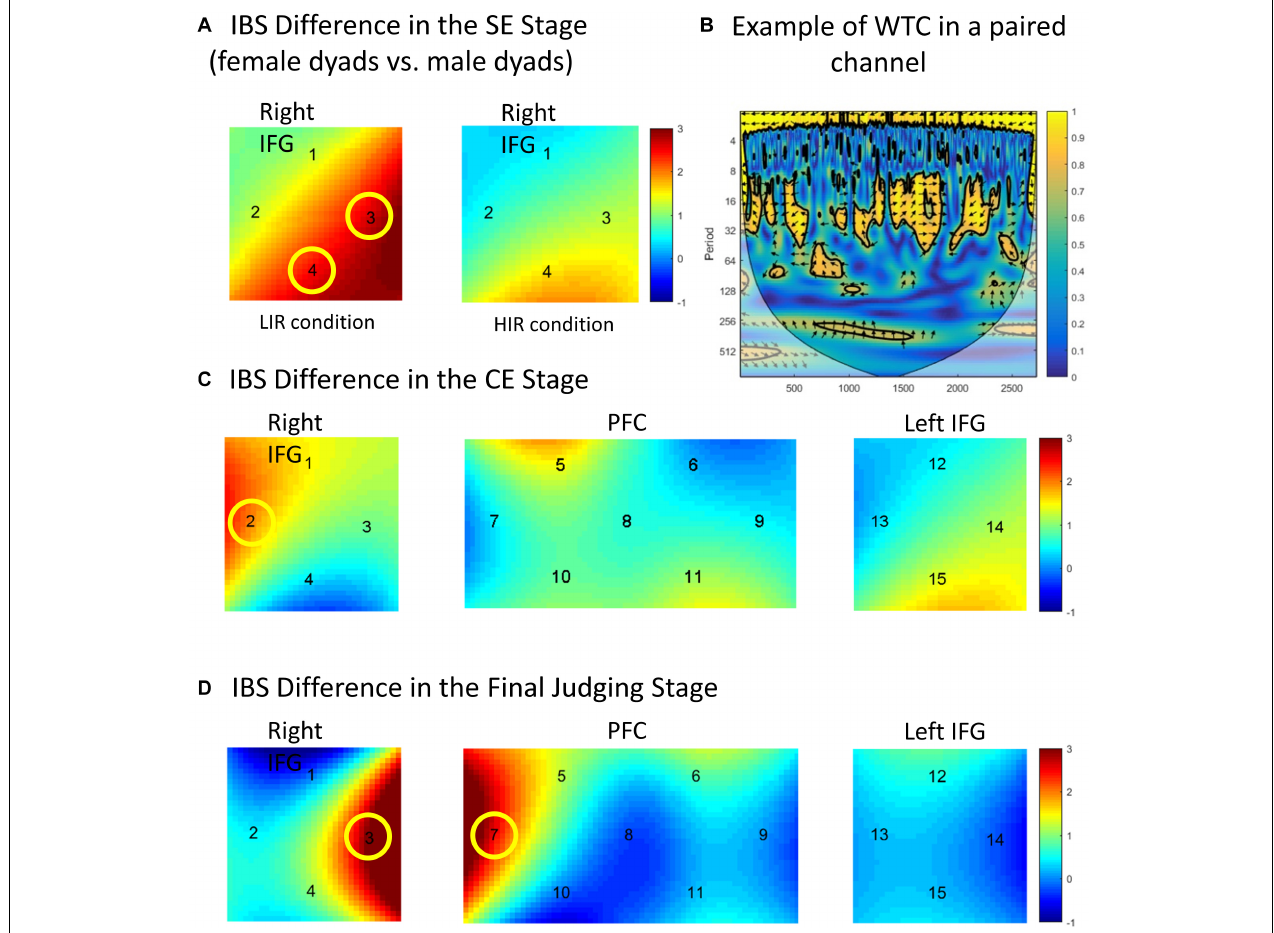
FIGURE 3 | (A) Interbrain synchrony (IBS) differences in the separate expectation stage. Female dyads evoked higher IBS than male dyads in the right inferior frontal gyrus (IFG) (CH 3 and 4) under the low incentive reward (LIR) condition. (B) Example of wavelet coherence. The data were from two participants’ the same channel (CH 1). (C) IBS differences in the co-expectation stage. IBS under the high incentive reward condition was higher than that under the LIR condition in the right IFG (CH 2). (D) IBS differences in the final judging stage. Successful team co-expectation yielded higher IBS than unsuccessful team co-expectation in the right IFG (CH 3) and the dorsal lateral prefrontal cortex (CH 7). Colored bars indicate t